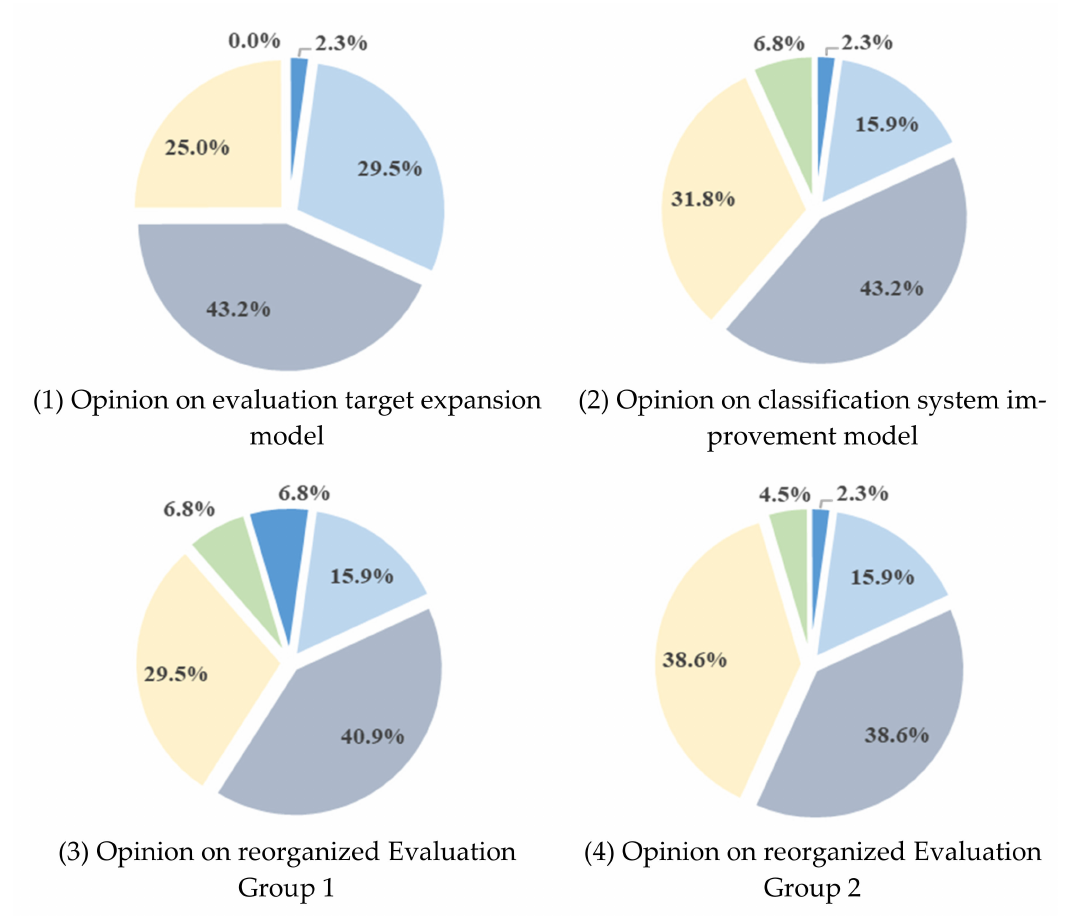
Figure 9. Survey results on existing systems: ( a ) recognition of the existing system; ( b ) experience and intention to participate in the existing